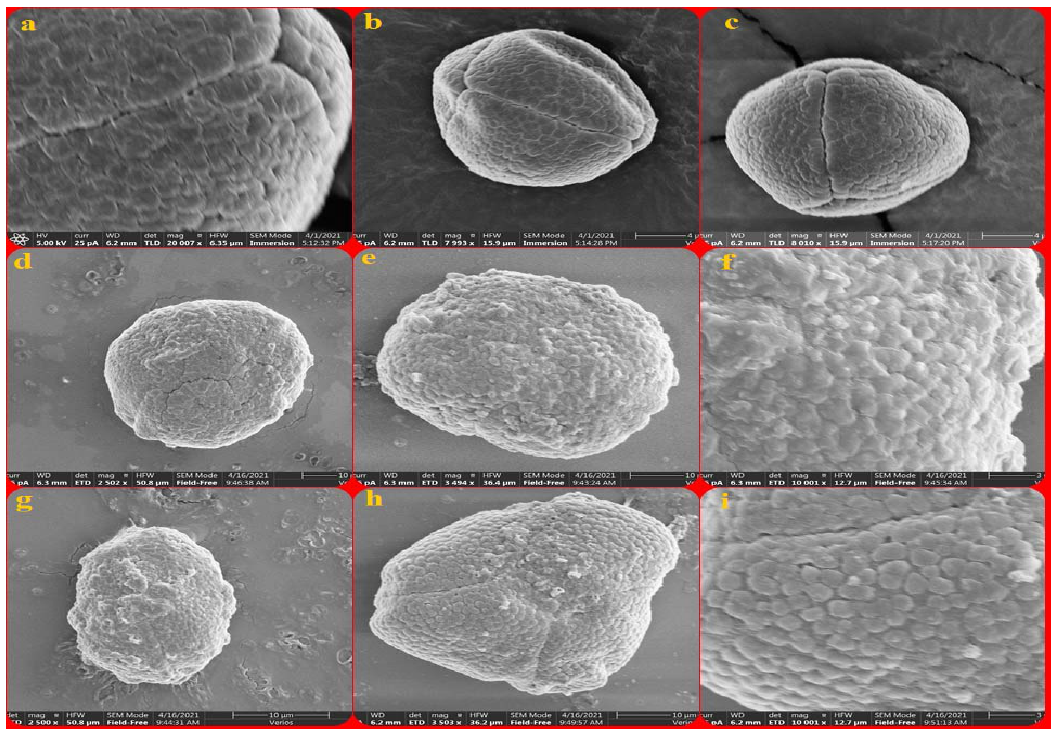
Figure 1. Acacia confusa ( a – c ), showing ( a ) general view of the pollen and ( b ) close view of the exine sculpturing. Entada phaseoloides ( d – g ), showing ( d ) oblique polar view, ( e ) equatorial view, ( f ) sunken colpus and ( g ) zonocolpus. Mimosa pudica Wanning ( h , i ), showing oblique equatorial